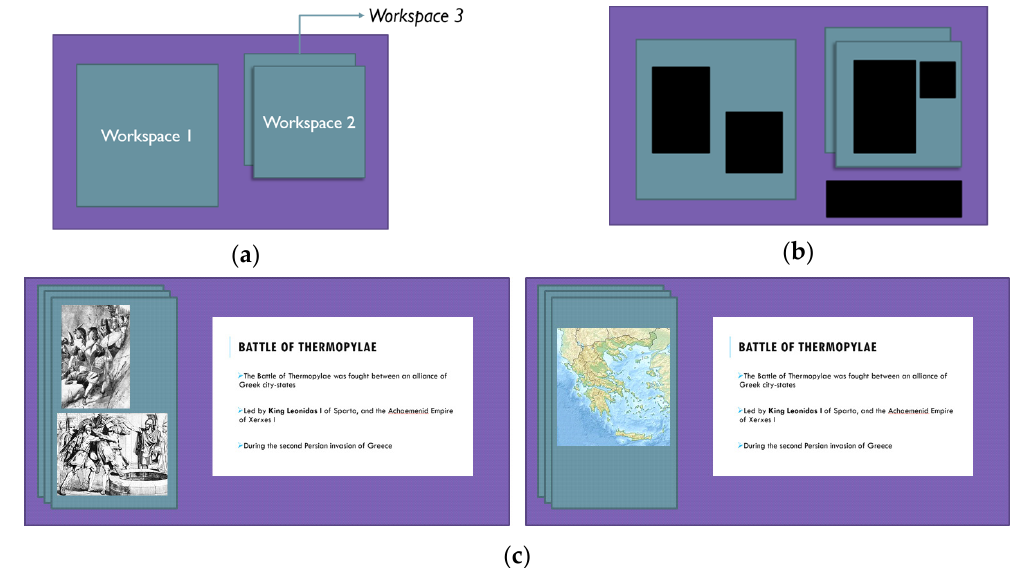
Figure 7. ( a ) Several workspaces can be created on the board, and behind each visible workspace there is the opportunity to create other workspaces of the exact same dimension. ( b ) Applications can be grouped and organized in a workspace. ( c ) Representation of alternative workspaces.